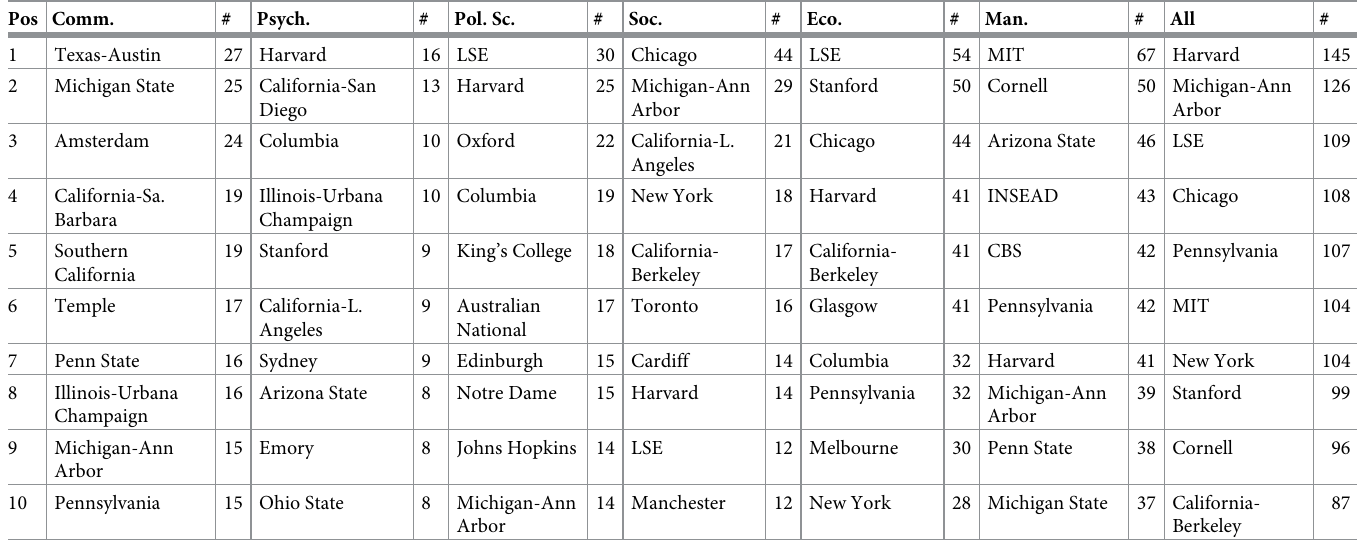
Table 7. Institutional representation of EBs for each field and for the overall network. Pos Comm.